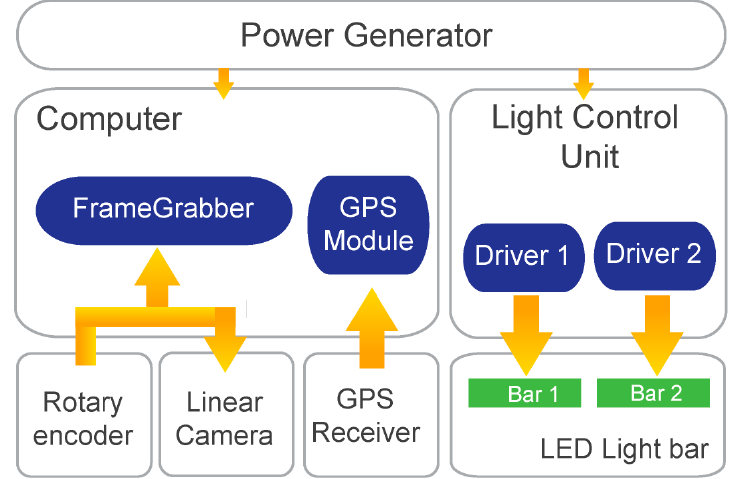
Figure 3. System architecture of the developed solution.